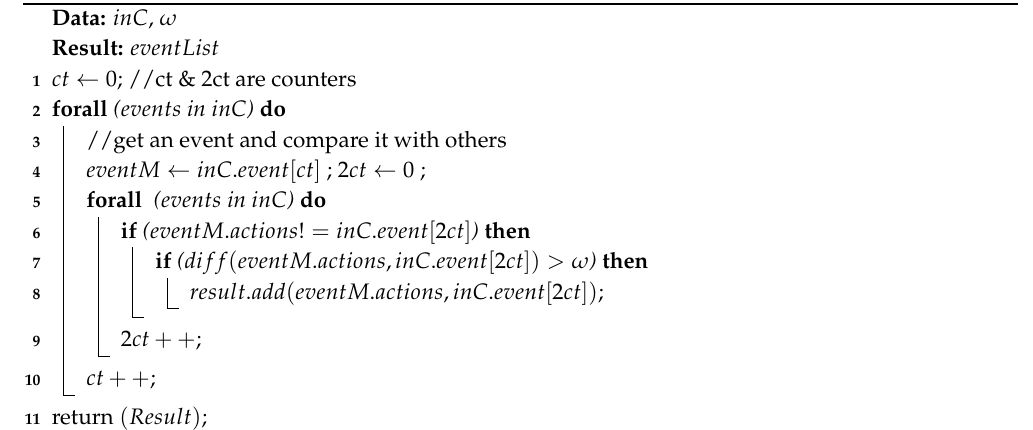
Algorithm 2: Contrast behavior identification from events inside a